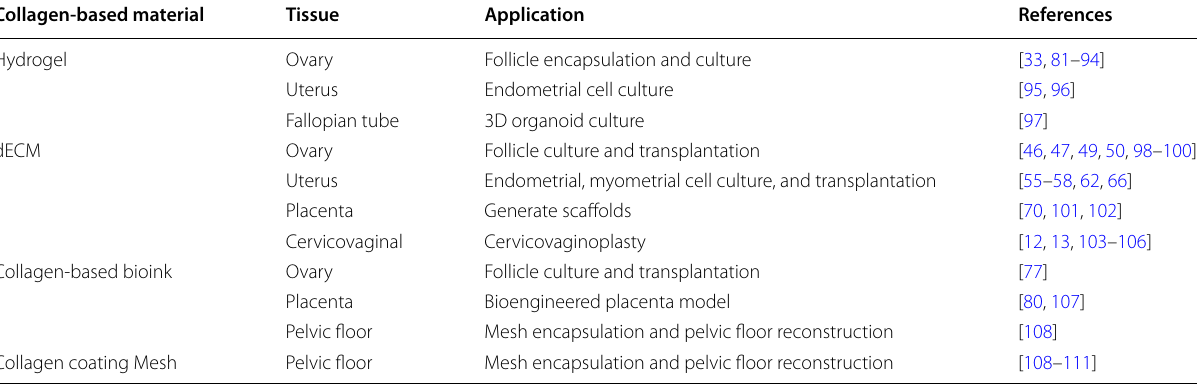
Table 1 Overview of recent studies in collagen-based materials in reproductive medicine and engineered reproductive tissues Collagen‑based material Tissue